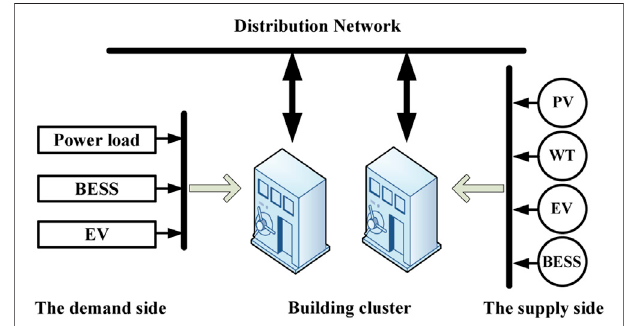
FIGURE 1 | Schematic of the multi-source DN.